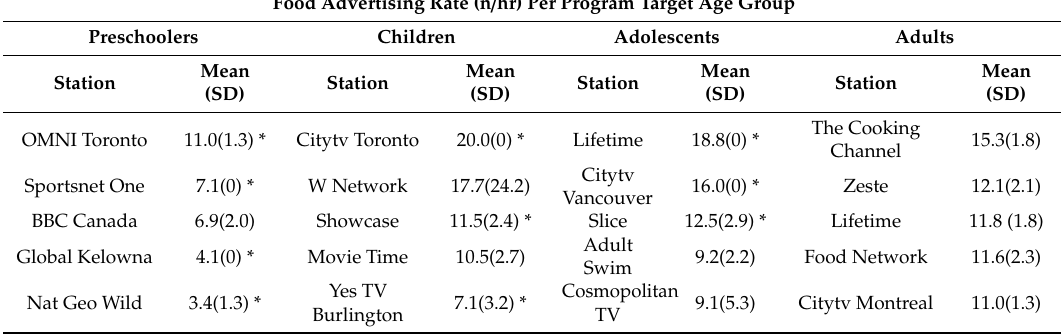
Table 3. Average food advertising rates (n / hr) among top five non-child-specialty Canadian television stations, per target program age group, in